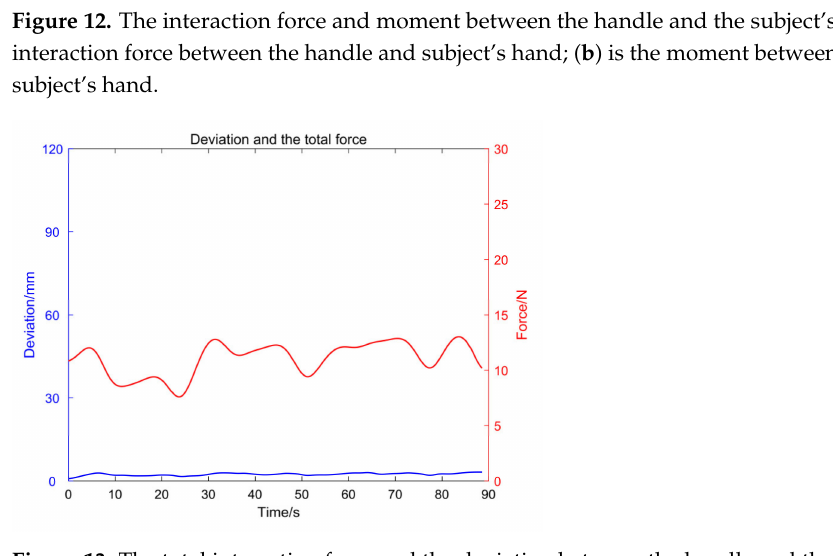
Figure 13. The total interaction force and the deviation between the handle and the subject’s